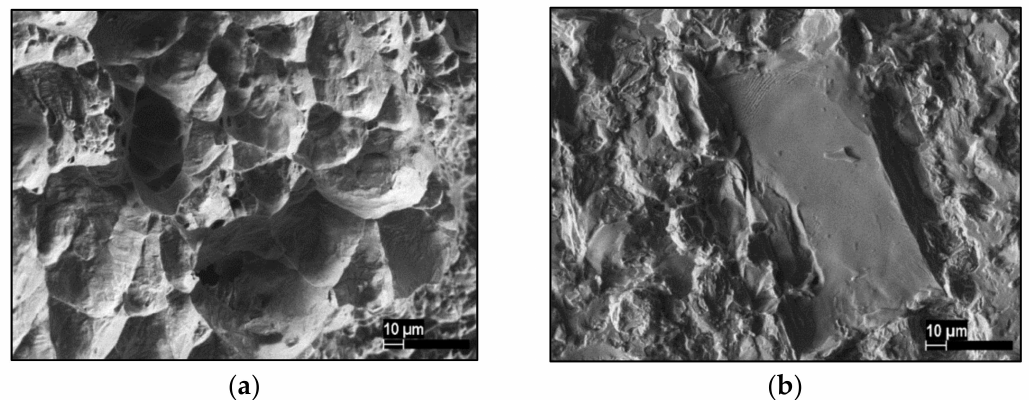
Figure 20. Fracture surfaces after impact tests of ( a ) ST07 40min and ( b ) ST20